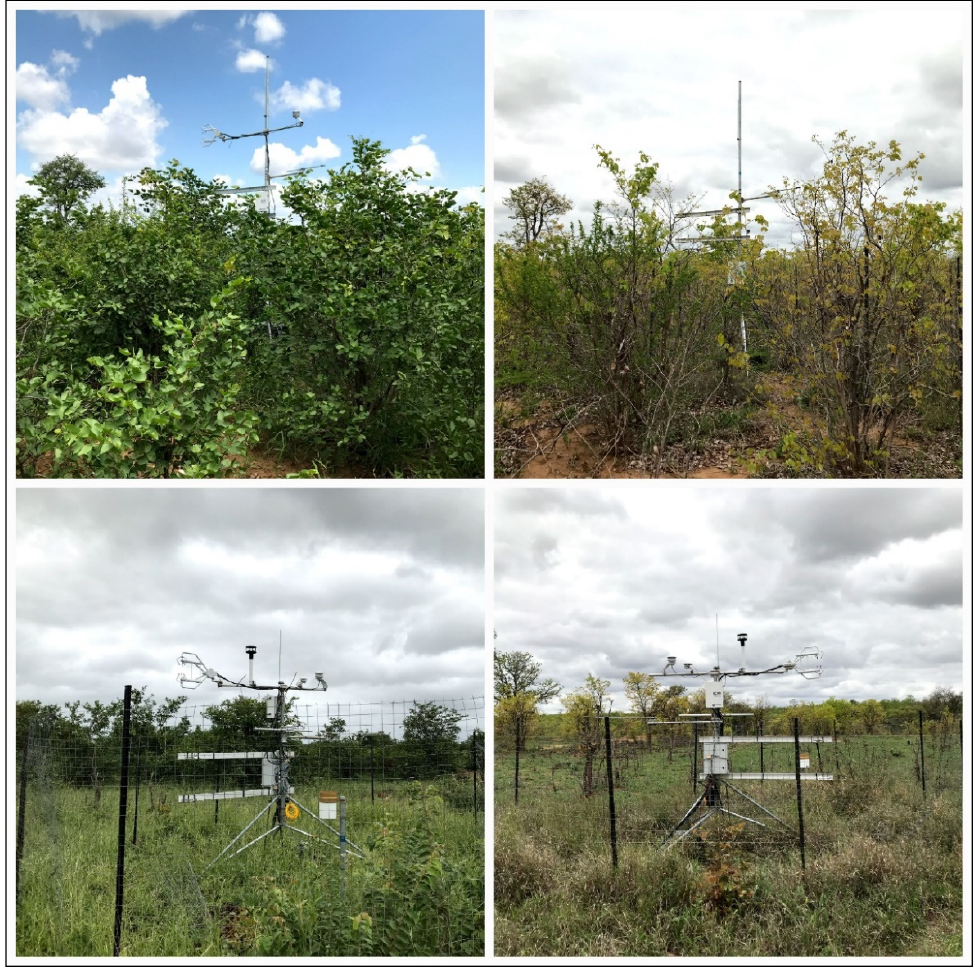
Figure 2. Vegetation and research equipment at the control plot in the summer ( top-left ) and spring ( top-right ) campaigns, and the cut plot in the summer ( bottom-left ) and spring ( bottom-right ) campaigns.